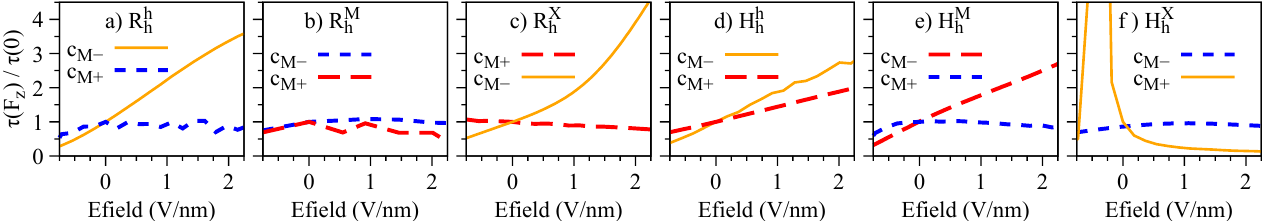
Figure 13. Calculated ratio τ rad ( F z ) / τ rad ( 0 ) as a function of the electric field for ( a ) R h ( d ) H h , ( e ) H M , and ( f ) H X stackings. We use E 0 = 1.35 eV for all cases, and the calculated values of h h h